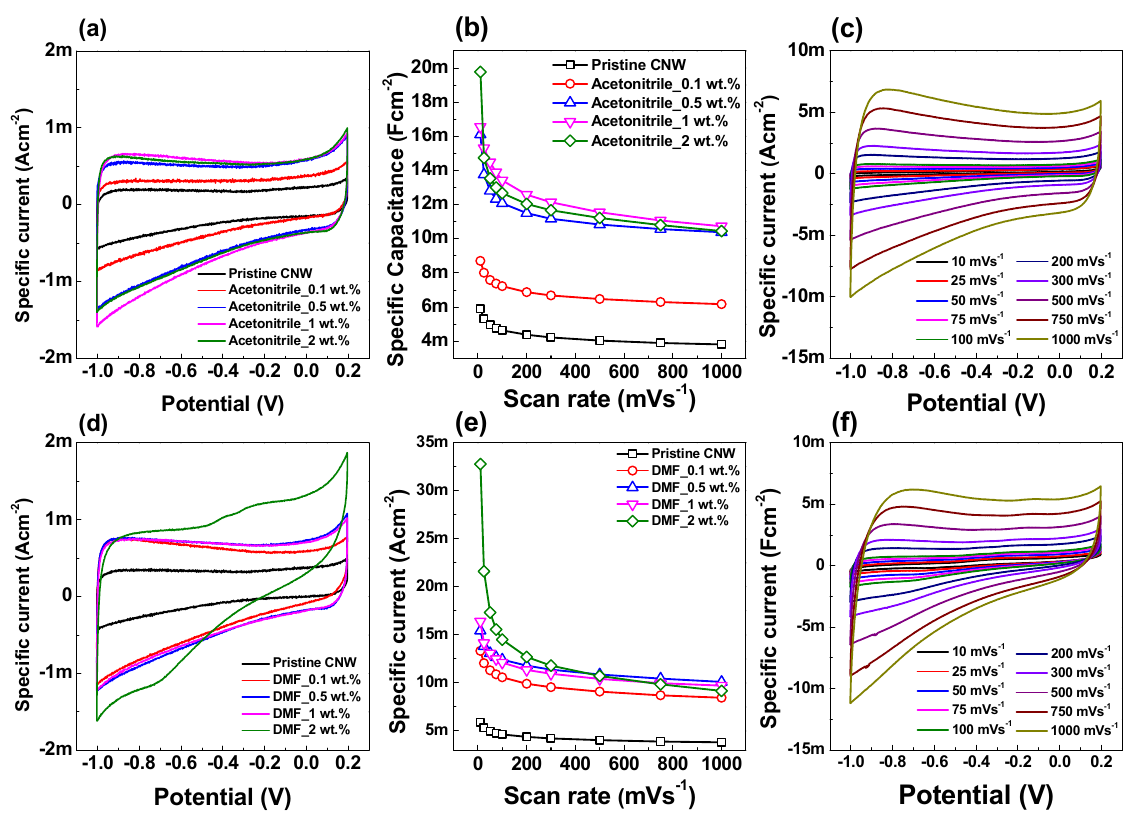
Figure 4. Cyclic voltammograms of the MoS 2 –CNW hybrid electrodes: ( a ) AM–CNW samples at 10 mVs − 1 scan rate, ( b ) specific capacitance variation with scan rates in the range of 10–1000 mVs − 1 , ( c ) cyclic vol-tammetry (CV) curve of 2 wt.% ATTM in the AM–CNW samples, ( d ) DM–CNW samples at 10 mVs − 1 scan rate, ( e ) specific capacitance variation with scan rates in the range of 10–1000 mVs − 1 , and ( f ) CV curves of the 2 wt.% ATTM in DM–CNW samples. The cyclic voltammograms of the AM–CNW samples present an archetypal horizontal straight curve without any significant redox peaks within the operating potential range, which implies that the MoS 2 –CNW composites can function as an EDLC and store charge by adsorbing ions on the electrode − electrolyte interface (Figure 4a) [69]. Compared with the capacitance value of 6 mFcm − 2 for pristine CNW, the specific capacitance of AM–CNW also increased to 8.7, 16, 17, and 20 mFcm − 2 with increasing ATTM concentration from 0.1 to 2 wt.% at a scan rate 10 mVs − 1 (Figure 4b). This was attributed to the increase in the effective contact area, as shown in the SEM images of the AM–CNW samples. Figure 4b shows plots of the calculated specific capacitance values with increasing scan rate and ATTM concentration. As the scan rate increased, the specific capacitance value decreased from 8.7, 16, 17, and 20 mFcm − 2 to 6.2, 10, 11, and 10 mFcm − 2 for the 0.1, 0.5, 1, and 2 wt.% ATTM concentrations, respectively. Further, as the scan rate was increased from 10 to 1000 mVs − 1 , the CV curves retained a quasi-rectangular shape without any significant deformation. This indicates that AM–CNW works mainly through an electrical double-layer capacitive charge storage mechanism and displays a good fast charge–discharge performance On the other hand, the 2 wt.% DM–CNW sample (Figure 4d) presented small reversible redox peaks at 0.2 and − 0.72 V, indicating that the faradaic process of MoS 2 contributes to increased capacitance. The two reversible redox peaks were attributed to the oxidation– reduction process of the Mo atoms by the process of Mo 4+ ↔ Mo 5+ ↔ Mo 6+ [70]. The voltammograms of all of the hybrid samples demonstrate excellent stability at high scan rates. Figure 4e shows that the specific capacitance values of the 0.1–2 wt.% DM–CMW samples increased by 13, 15, 16, and 33 mFcm − 2 , respectively, compared to